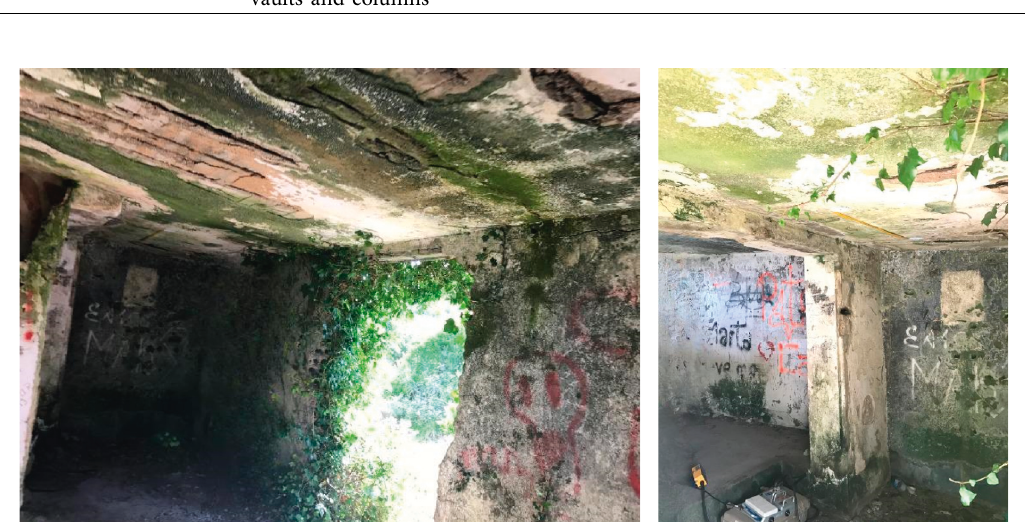
Figure 4: Interior of the military base in Cabo Udra, greatly affected by moisture and vegetation that can cause the corrosion of the metallic